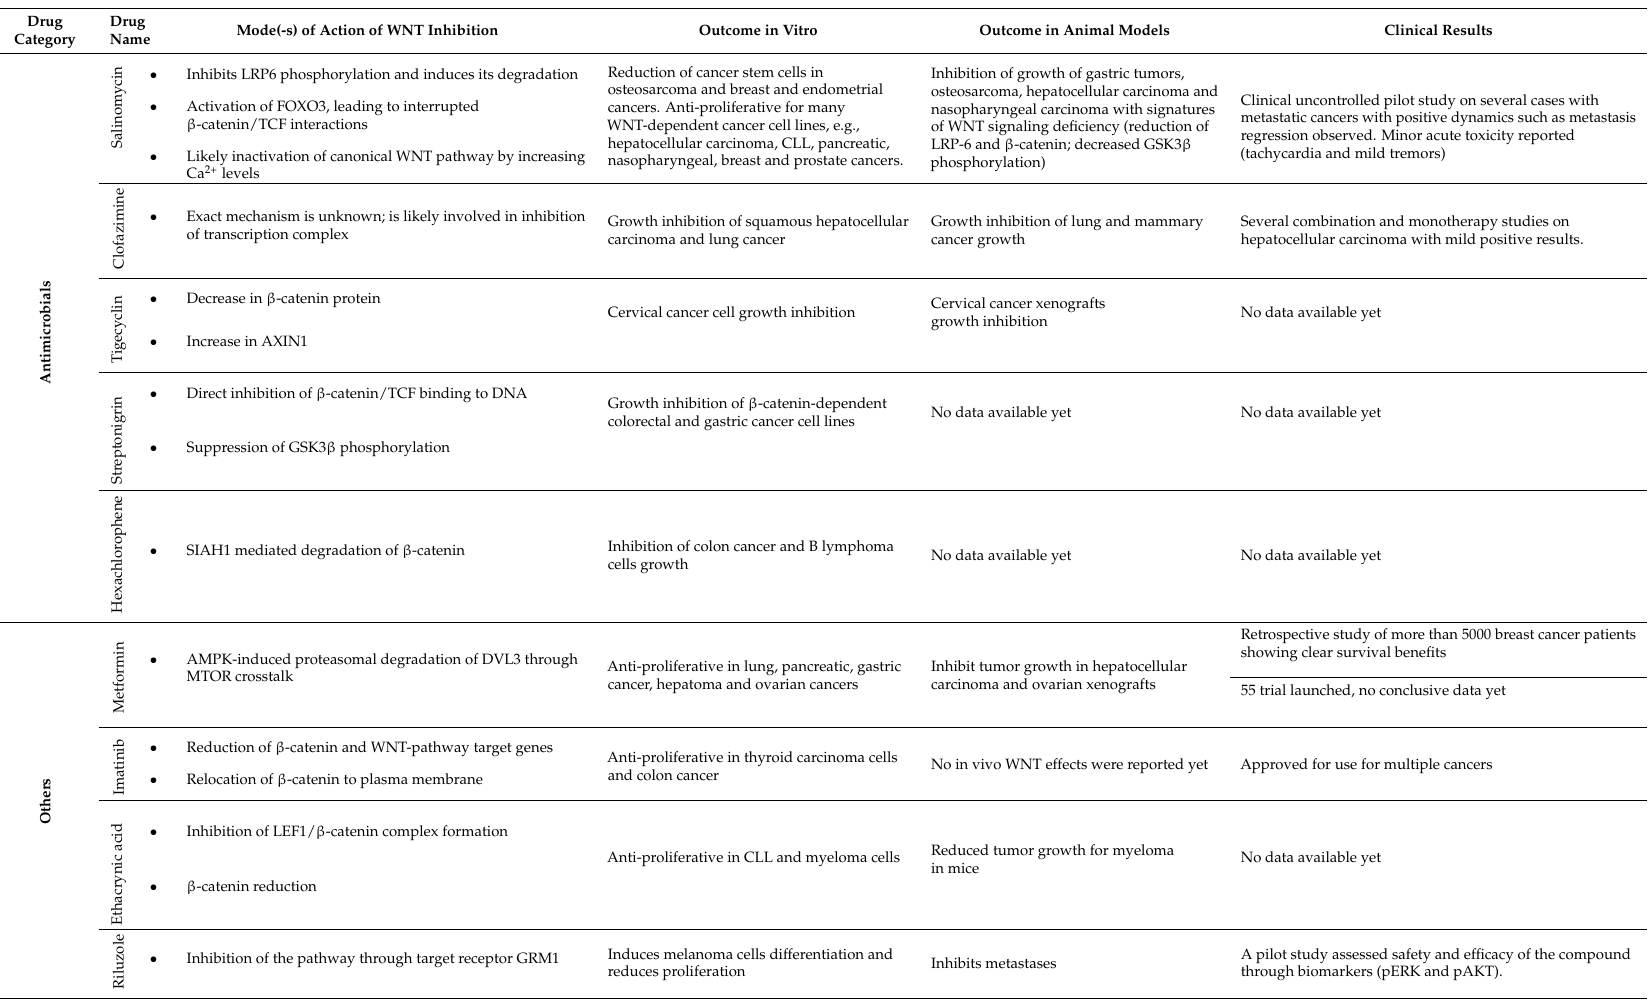
Apilotstudyassessedsafetyandefficacyofthecompound